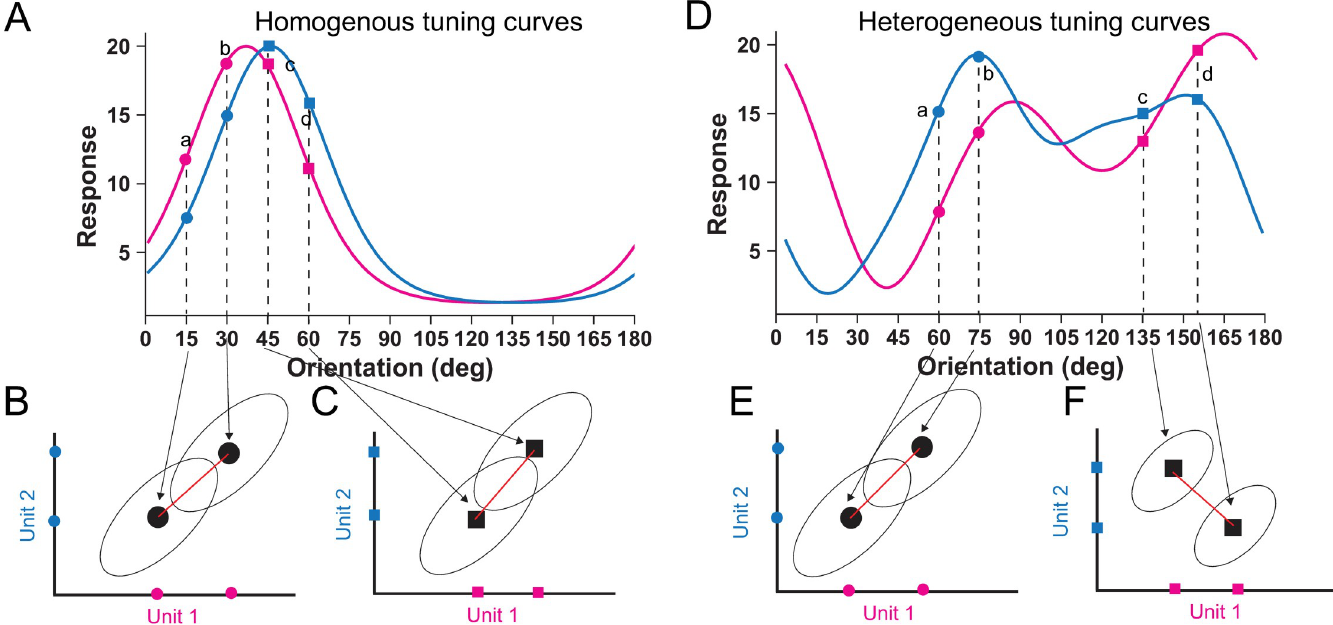
Fig 9. The detrimental effects of TCNCs and the beneficial effects of tuning heterogeneity. Panel A illustrates the scenario of homogeneous tuning curves of two units. Panels B and C depict the cases of classifying stimuli a and b and stimuli c and d, respectively. In both panels B and C, the noise correlation is detrimental. The dots or squares on the x- and y-axes indicate the mean responses of the two units towards the two stimuli. Panels D-F are similar to Panels A-C but illustrate the scenario of heterogeneous tuning curves. The noise correlation between the two units is detrimental to the classification of stimuli a and b, but beneficial to the classification of stimuli c and d. Panels D-F show how tuning heterogeneity can mitigate the detrimental effect of TCNC.